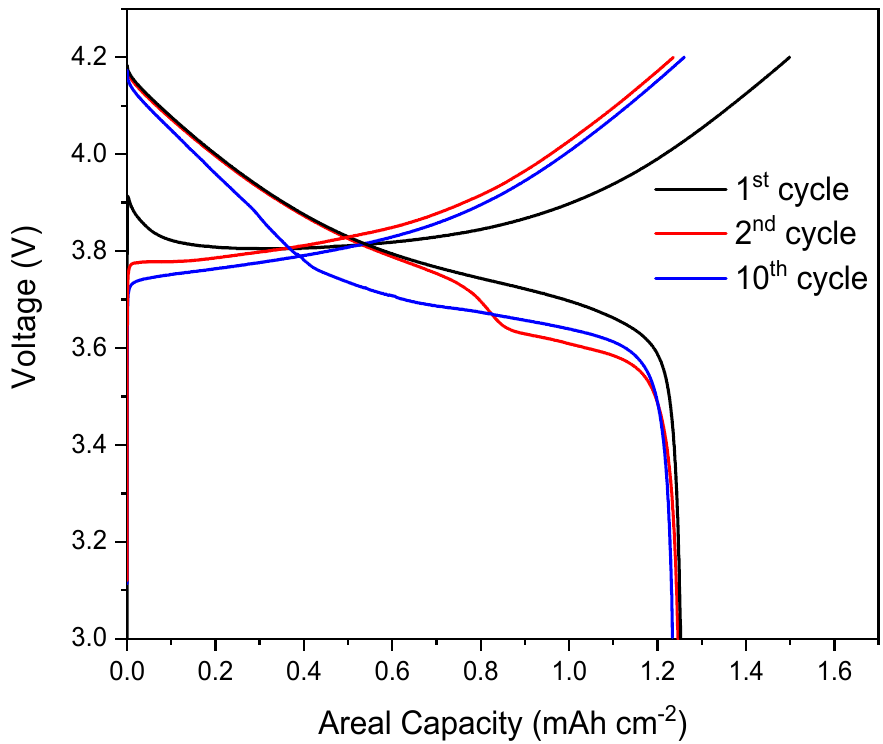
Figure 5. Charge and discharge curves for the 1st, 2nd, and 10th cycles for the NMC cell.